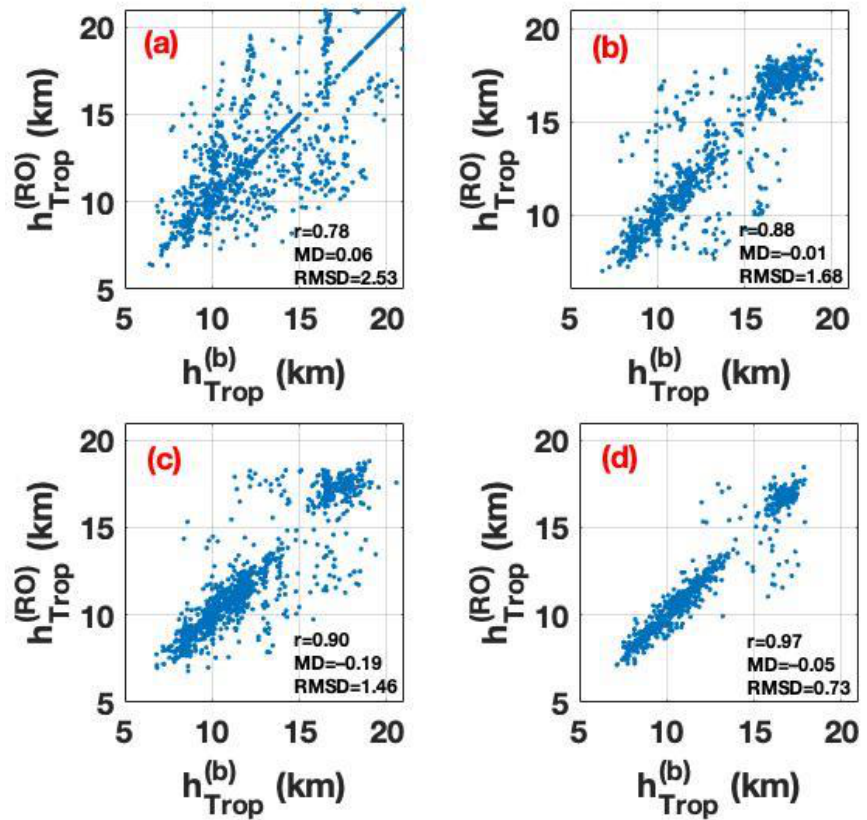
Figure 17. Scatterplots of the tropopause altitude as estimated by the real temperature profile ( x -axis) versus the tropopause altitudes by the RO observations ( y -axis), for ( a ) the LRT, ( b ) the CPT, ( c ) the weak CPT and ( d ) the weak LRT definitions.